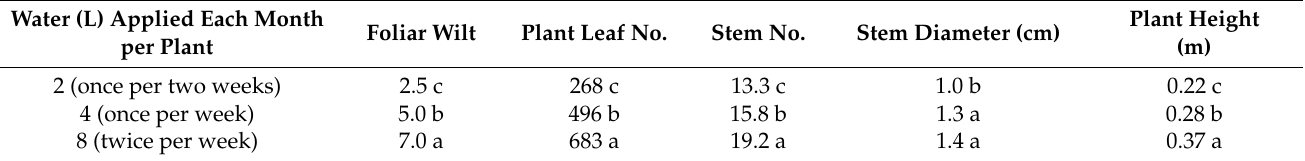
Table 3. Influence of watering regime on basil growth in an extensive green roof